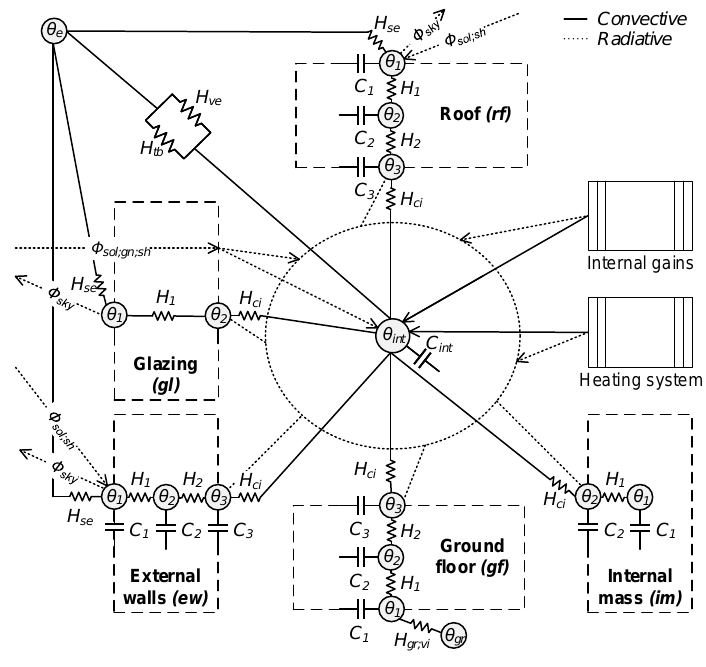
Figure 5. The thermal network used to represent the conditioned